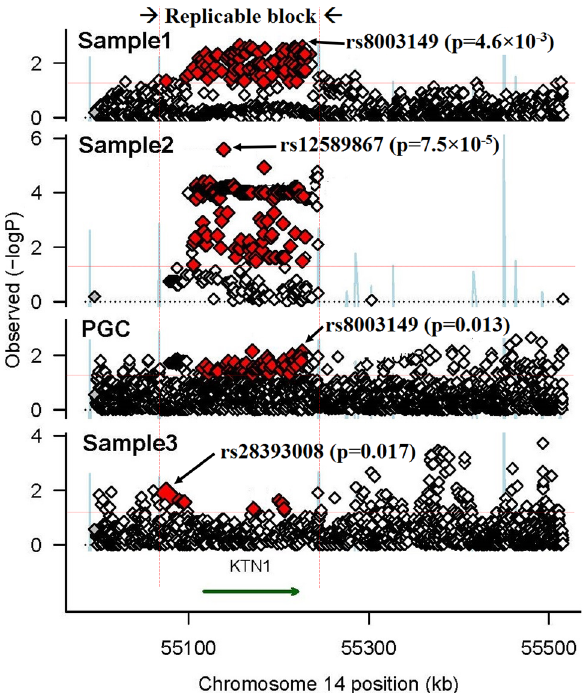
Figure 2. Regional association plots in four samples [X-axis, chromosome positions; Y-axis, −log(p) values; Sample names labeled at the left top corners correspond to Table 1; The most significant SNP with the lowest p-value in each plot is pointed by an arrow; Red diamonds are those SNPs with p < 0.05 and in high LD with one another; Red vertical dashed lines define the replicable association variant block; Red horizontal dashed line correspond to p =